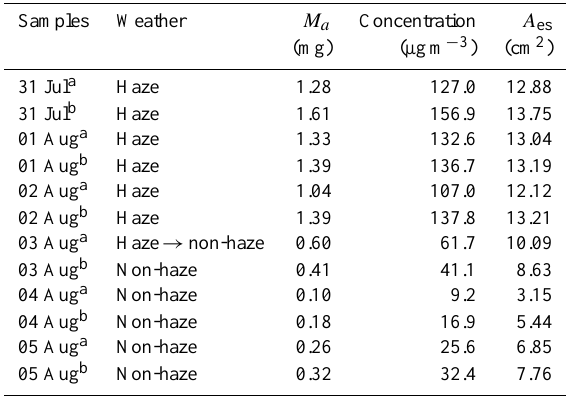
Note: a daytime; b nighttime; A es , effective surface area; M a , mass of PM 2 . 5 .